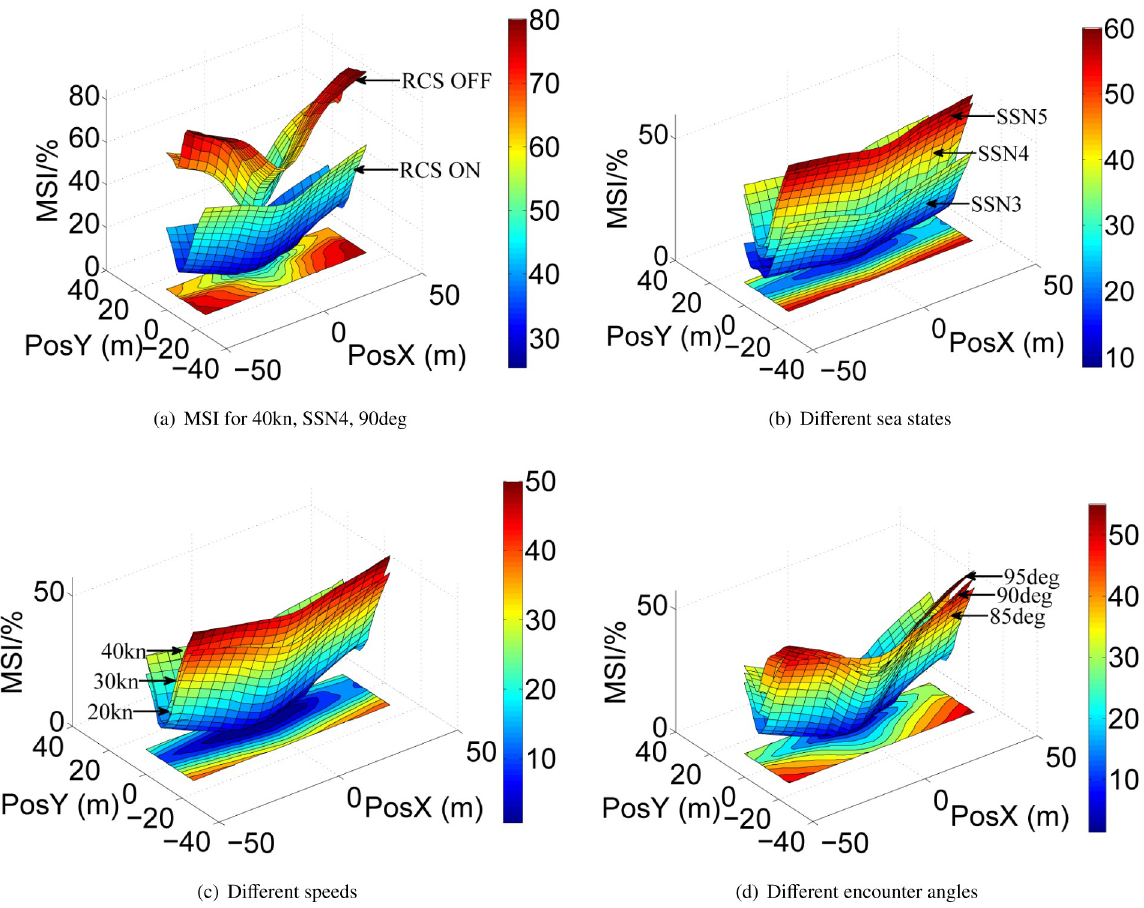
Fig 14. MSI for the WPC vessel in different conditions. (a) MSI for 40kn, SSN4, 90deg. (b) Different sea states. (c) Different speeds. (d) Different encounter angles.